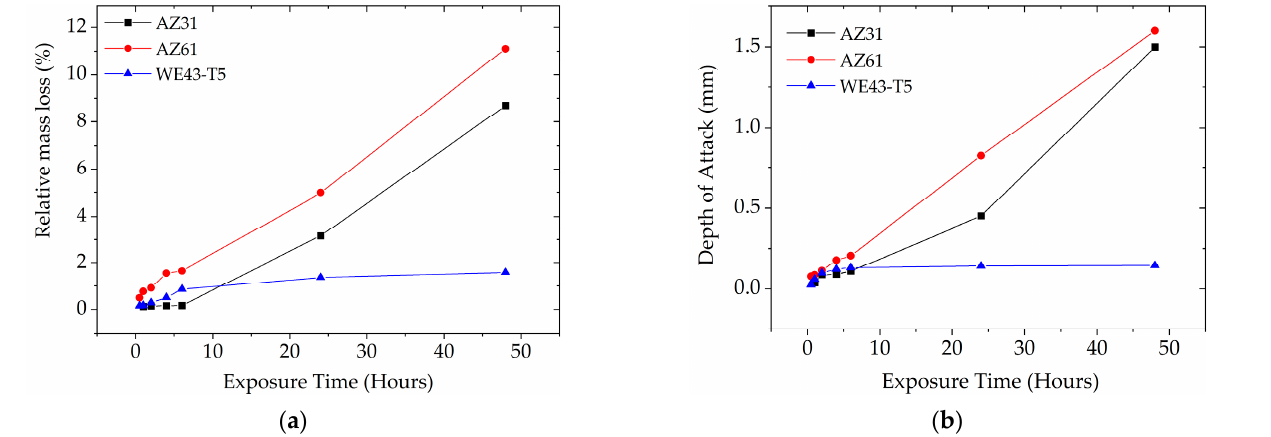
Figure 11. Comparison of: ( a ) relative mass loss and ( b ) maximum measured depth of attack of AZ31, AZ61, and WE43-T5 specimens as functions of exposure time.